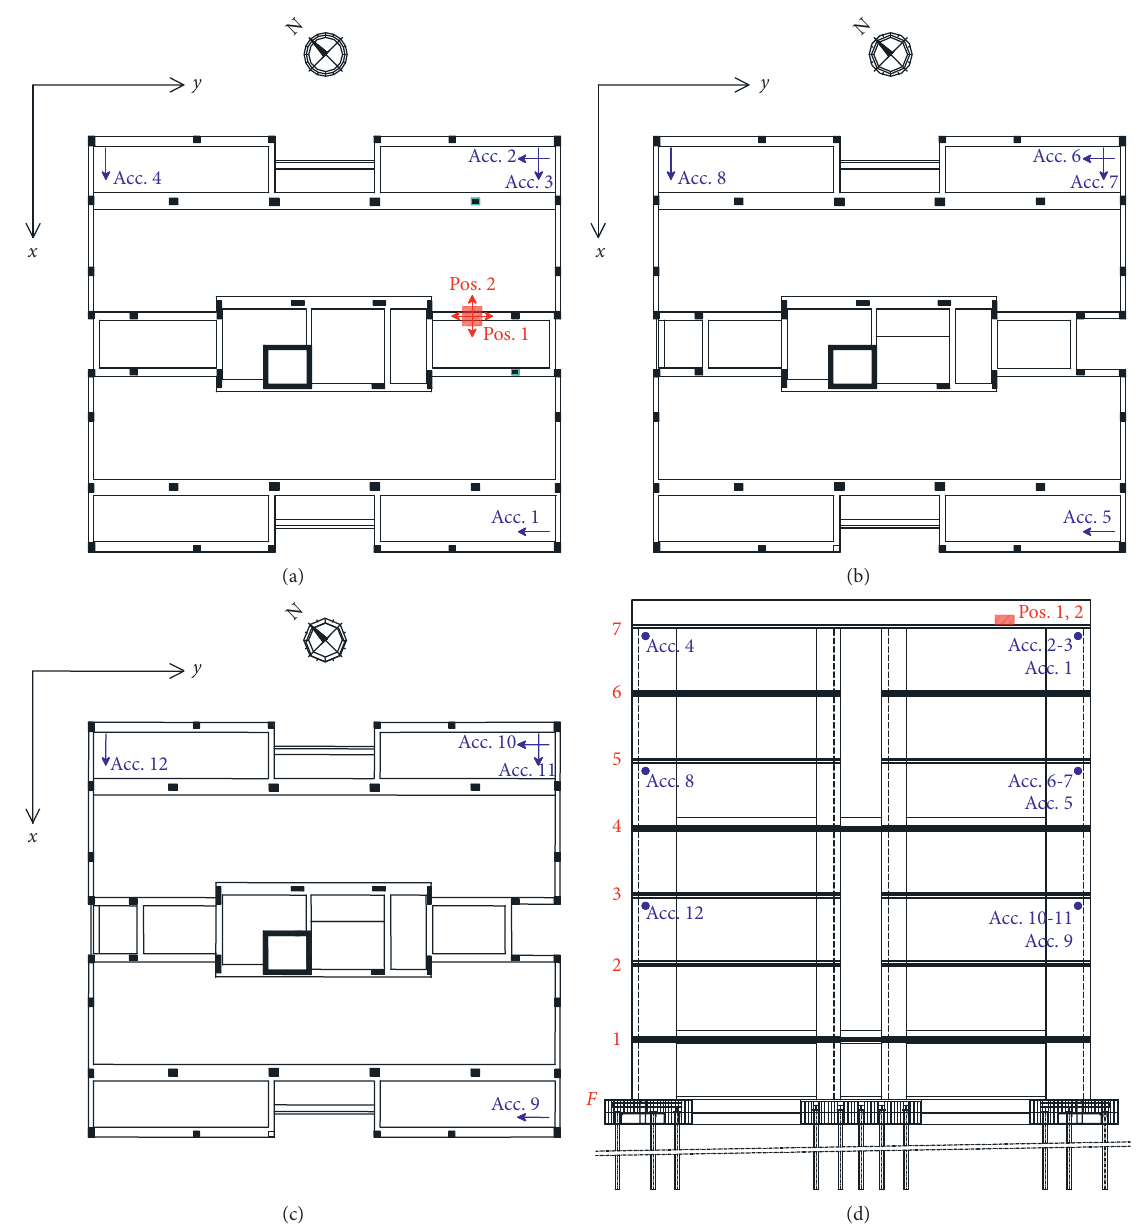
Figure 2: Positions of accelerometers and the vibration generator during the dynamic tests. (a) Plan view of floor #7 (roof floor); (b) plan view of floor #5; (c) plan view of floor #3; (d) vertical section of the